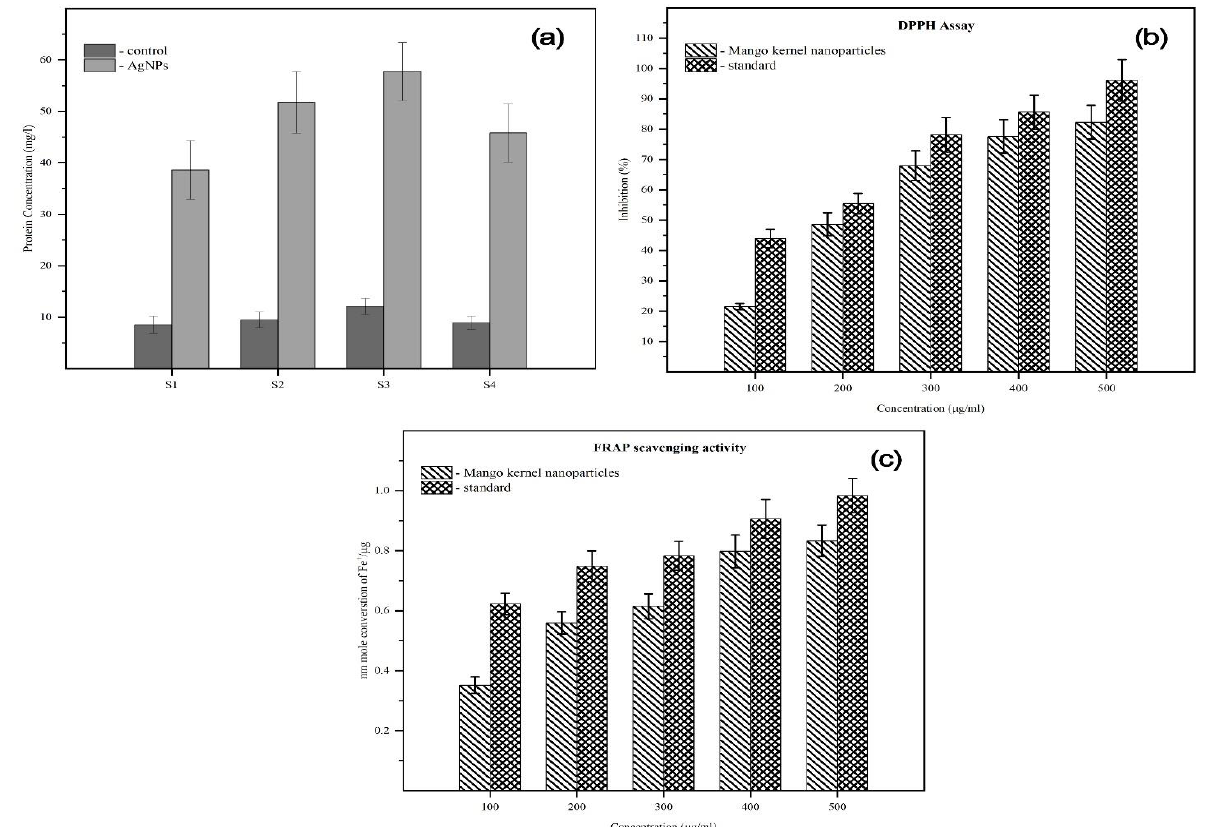
Figure 5. ( a ) Protein leakage assay. ( b , c ) DPPH and FRAP assay of MK-AgNPs.